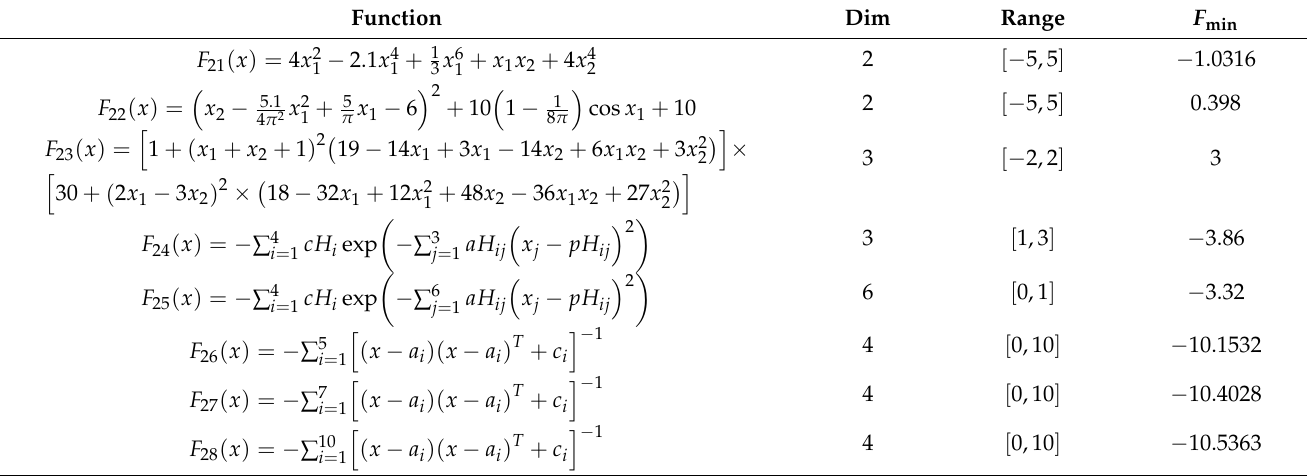
Table 3. Fixed-dimension multimodal benchmark